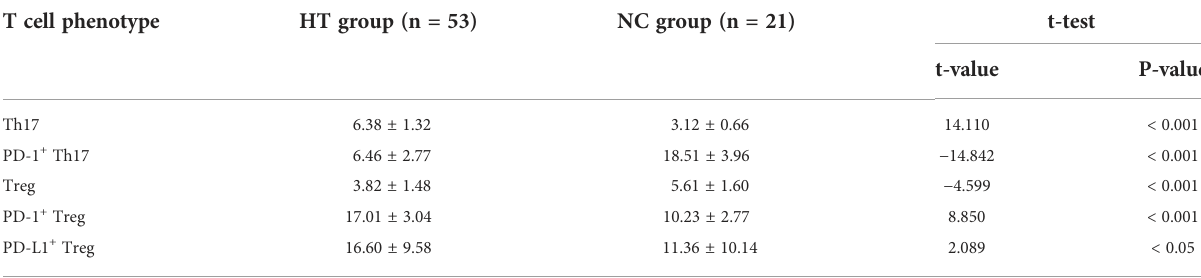
TABLE 2 Percentages of the peripheral blood T cell subsets statistically different between the HT and the NC groups. T cell